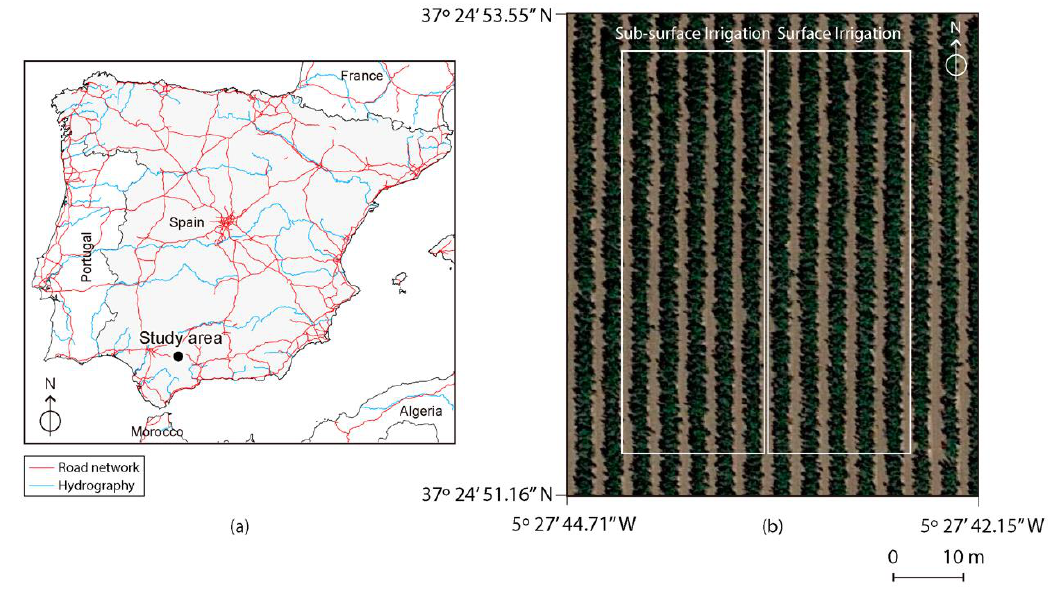
Figure 2. Study area: ( a ) Location; and ( b ) olive tree plantation details.